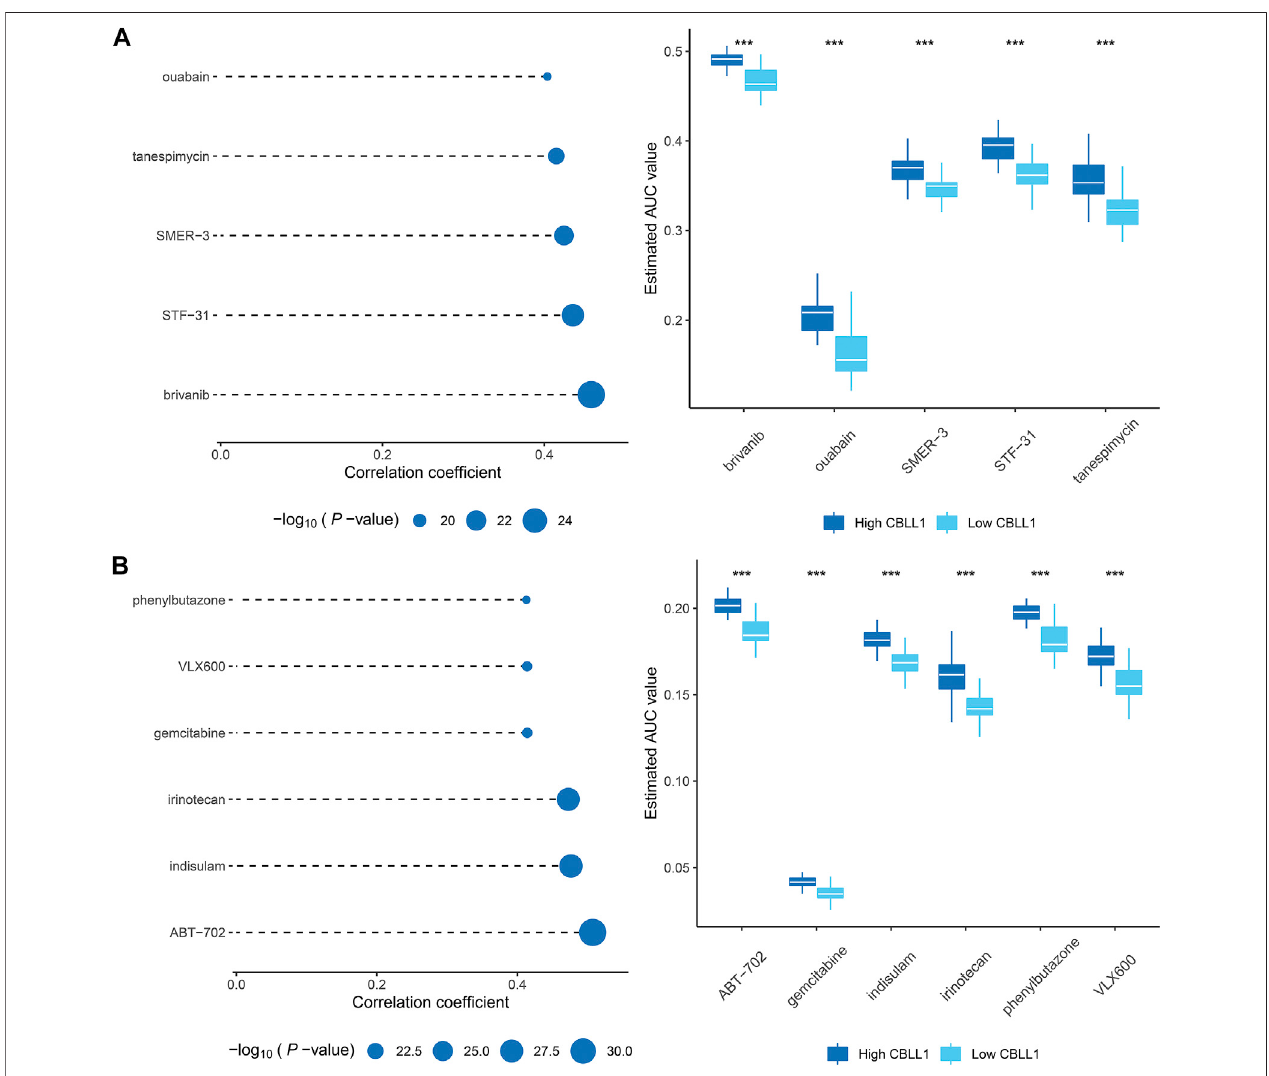
FIGURE 6 | Identi fi cation of potential therapeutic agents for PCa (A) The results of Spearman ’ s correlation analysis and differential drug response analysis of fi ve CTRP-derived compounds. (B) The results of Spearman ’ s correlation analysis and differential drug response analysis of six PRISM-derived compounds.